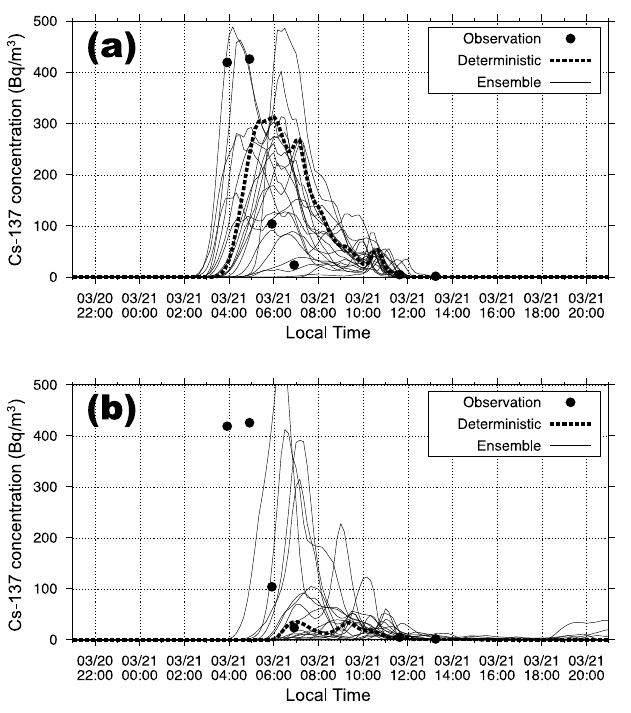
Figure 6. Same as Figure 3 but for the time period from 21:00 March 20 to 21:00 21 March local time. The forecasts were initiated at 21:00 20 March local time.